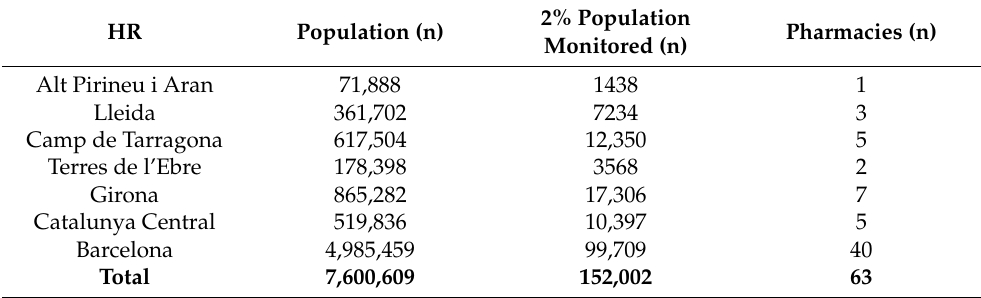
Table 2. Population analysis to obtain the minimum number of pharmacies in each HR.